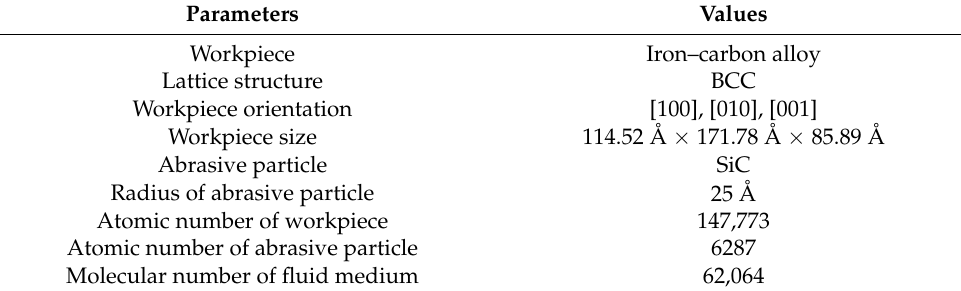
Figure 1. MD simulation system. ( a ) Wet cutting; and ( b ) dry cutting. Table 1. Model